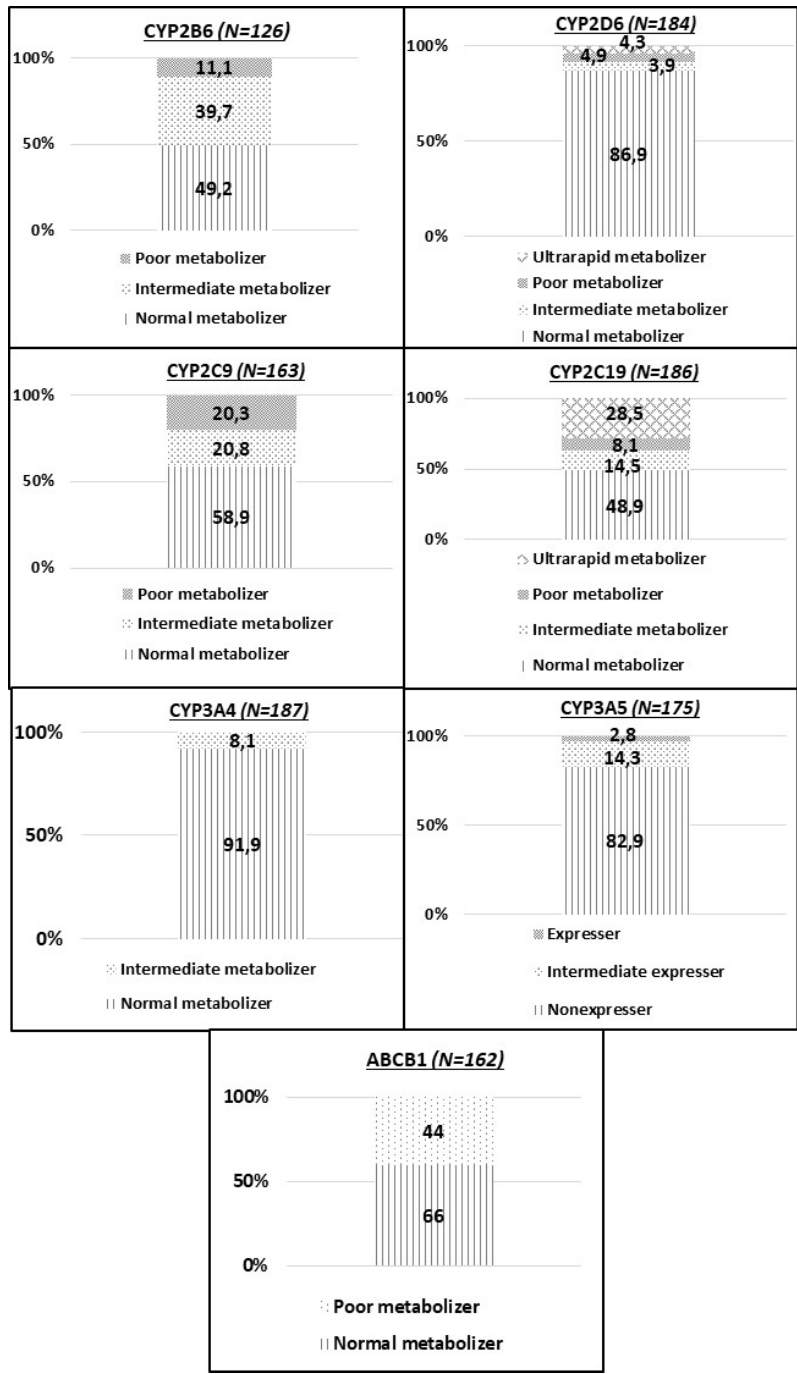
Figure 3. Distribution of evaluated cytochrome P-450 (CYP) metabolic phenotypes in the study population.